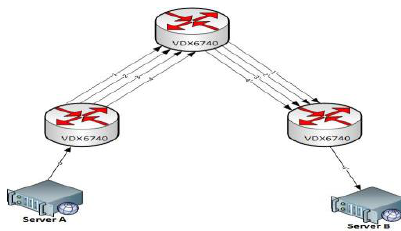
Fig. 3. Similar data communication paths between two networks